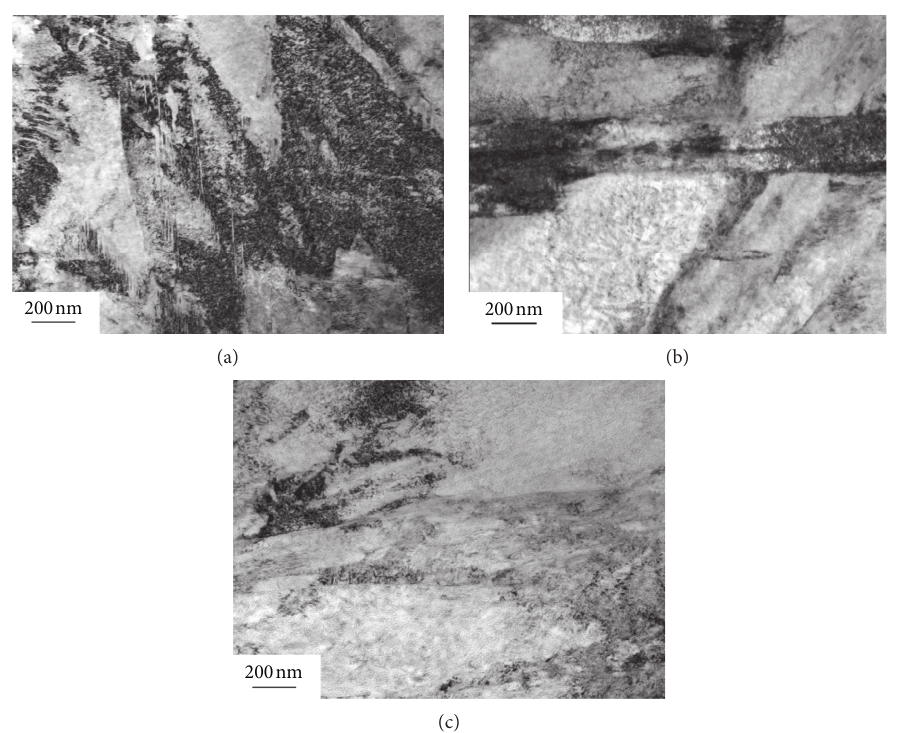
Figure 7: TEM microstructures of as-cast 42CrMo alloy during nonisothermal compression conditions: (a) sample 14; (b) sample 8; (c) sample